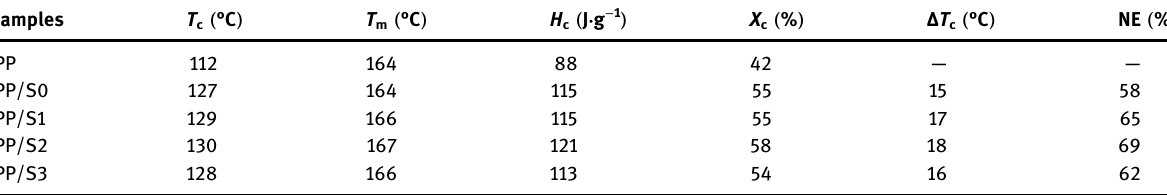
Table 2: The corresponding parameters from crystallization and melting curves